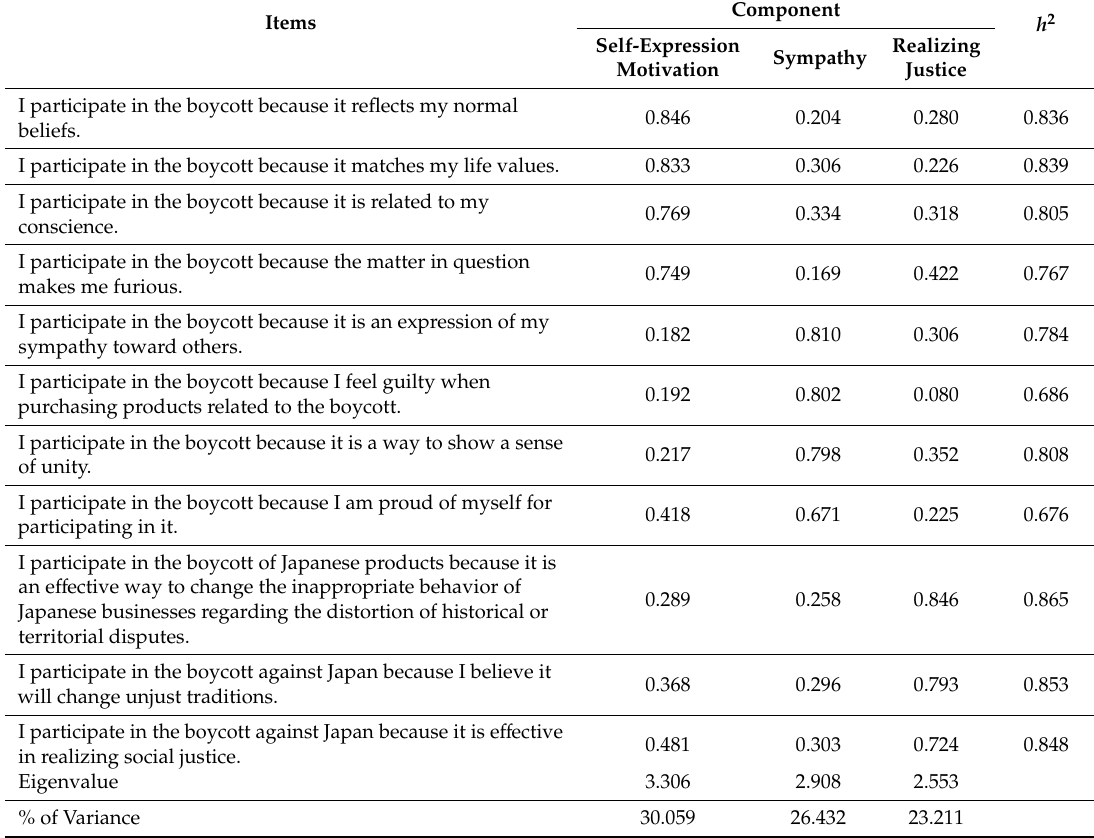
Table 2. Principle components analysis (PCA) with varimax rotation: Boycott motivation and item